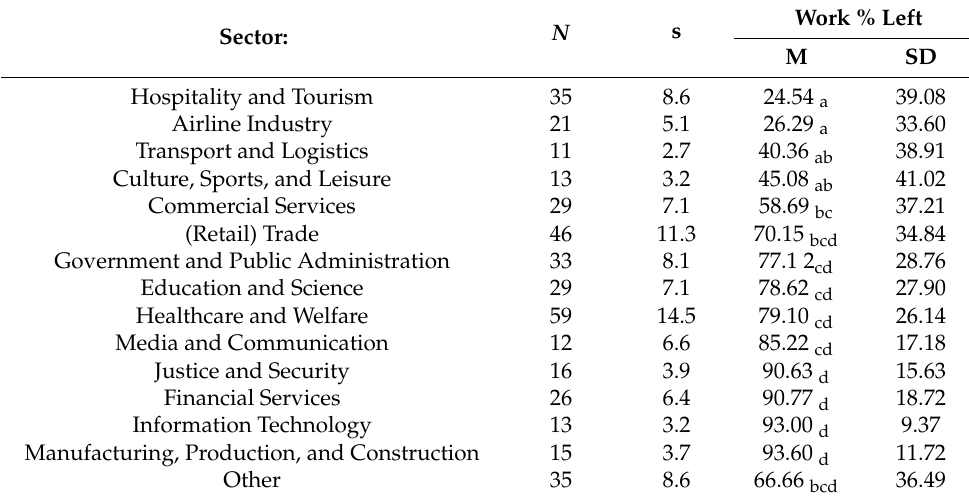
Table 1. Distribution of respondents among sectors and differences in work percentage left be- tween